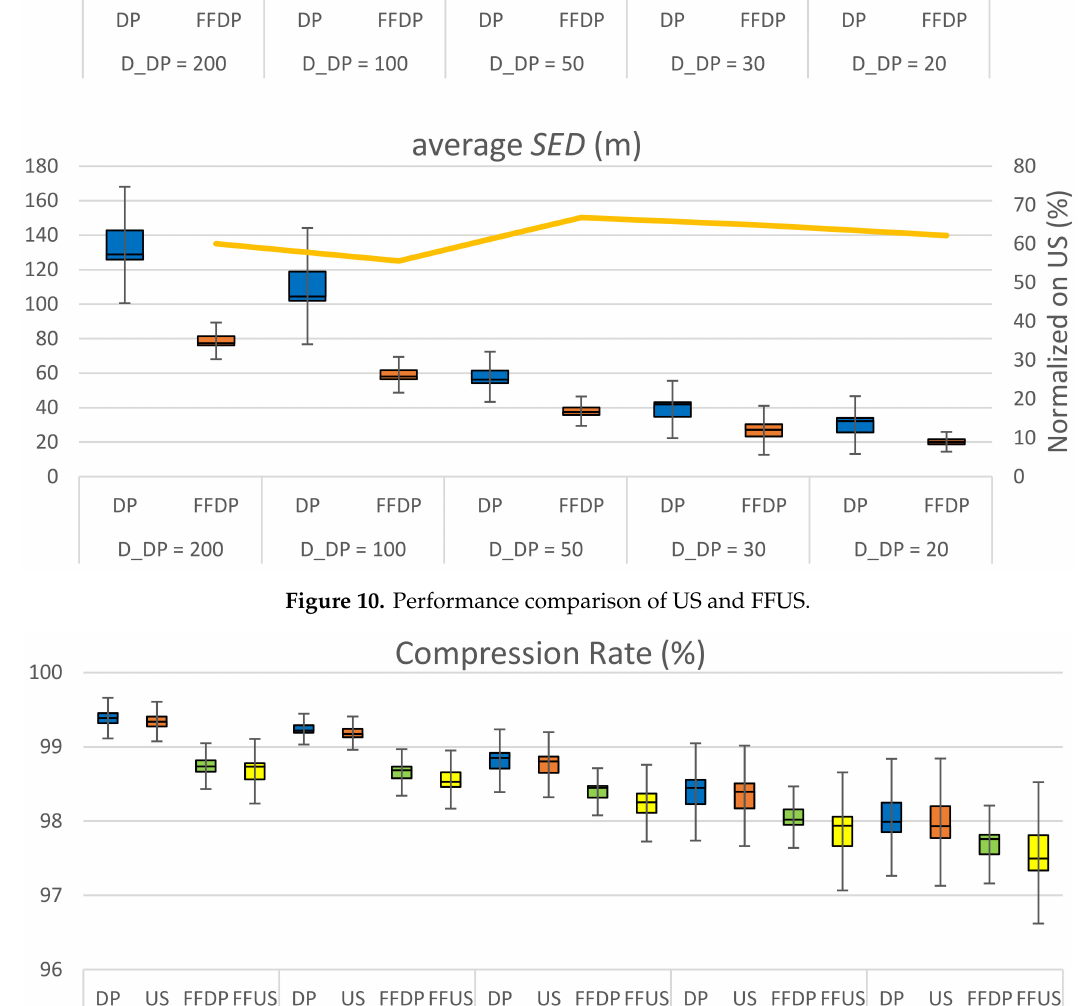
Figure 11. Comparison of compression rates of di ff erent simplification